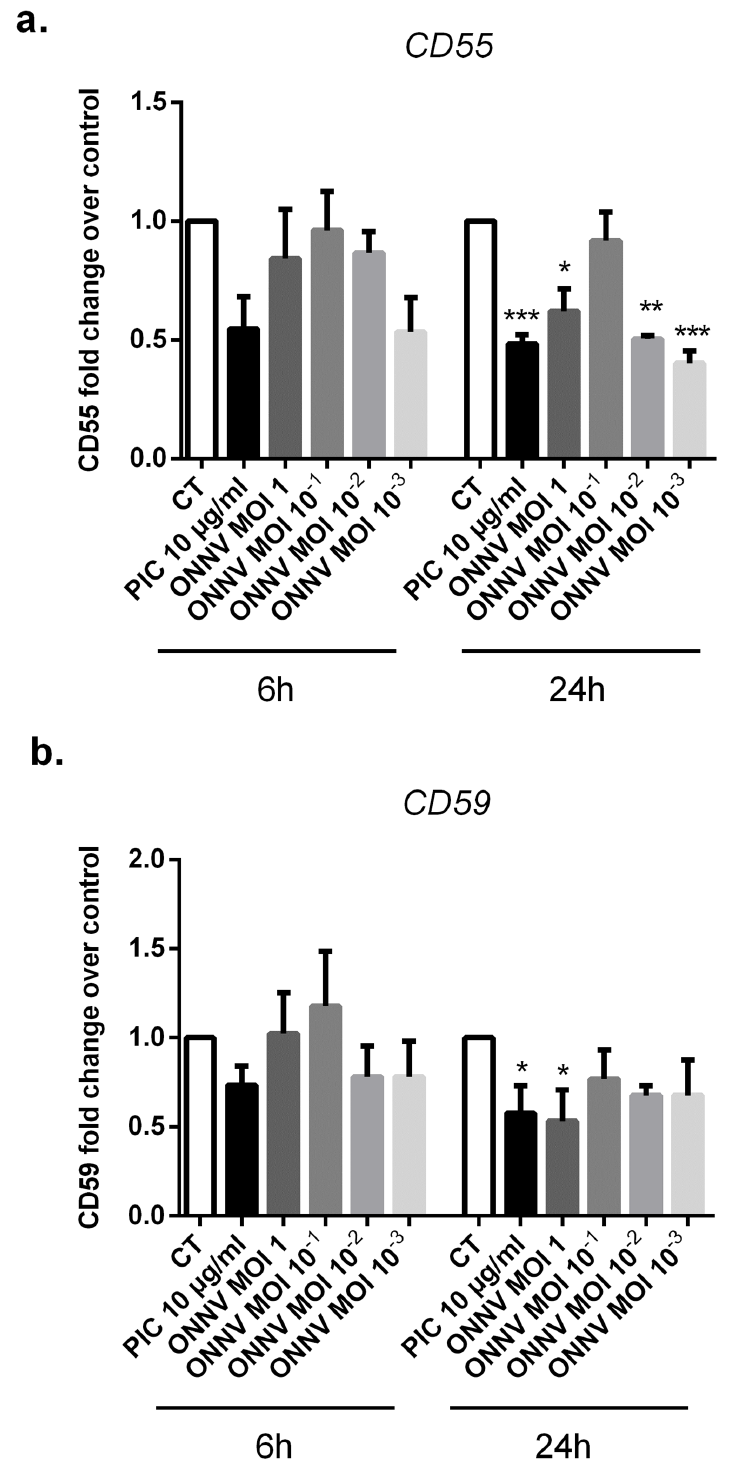
Figure 10. mRNA expression of two major complement regulatory proteins CD55 and CD59 are downregulated after ONNV infection. ( a ) CD55 and ( b ) CD59 mRNA levels were quantified by qRT-PCR in SC following ONNV (MOI 10 − 3 to 1) infection or exposure to PIC 10 µ g/mL for 6 h and 24 h. All experiments were done in triplicates. Results are expressed as mean ± SEM and presented as a normalized fold increase vs control. * p -values ≤ 0.05, ** p -values ≤ 0.01, and *** p -values ≤ 0.001 represent significant differences from controls by one-way ANOVA followed by the Bonferroni’s test